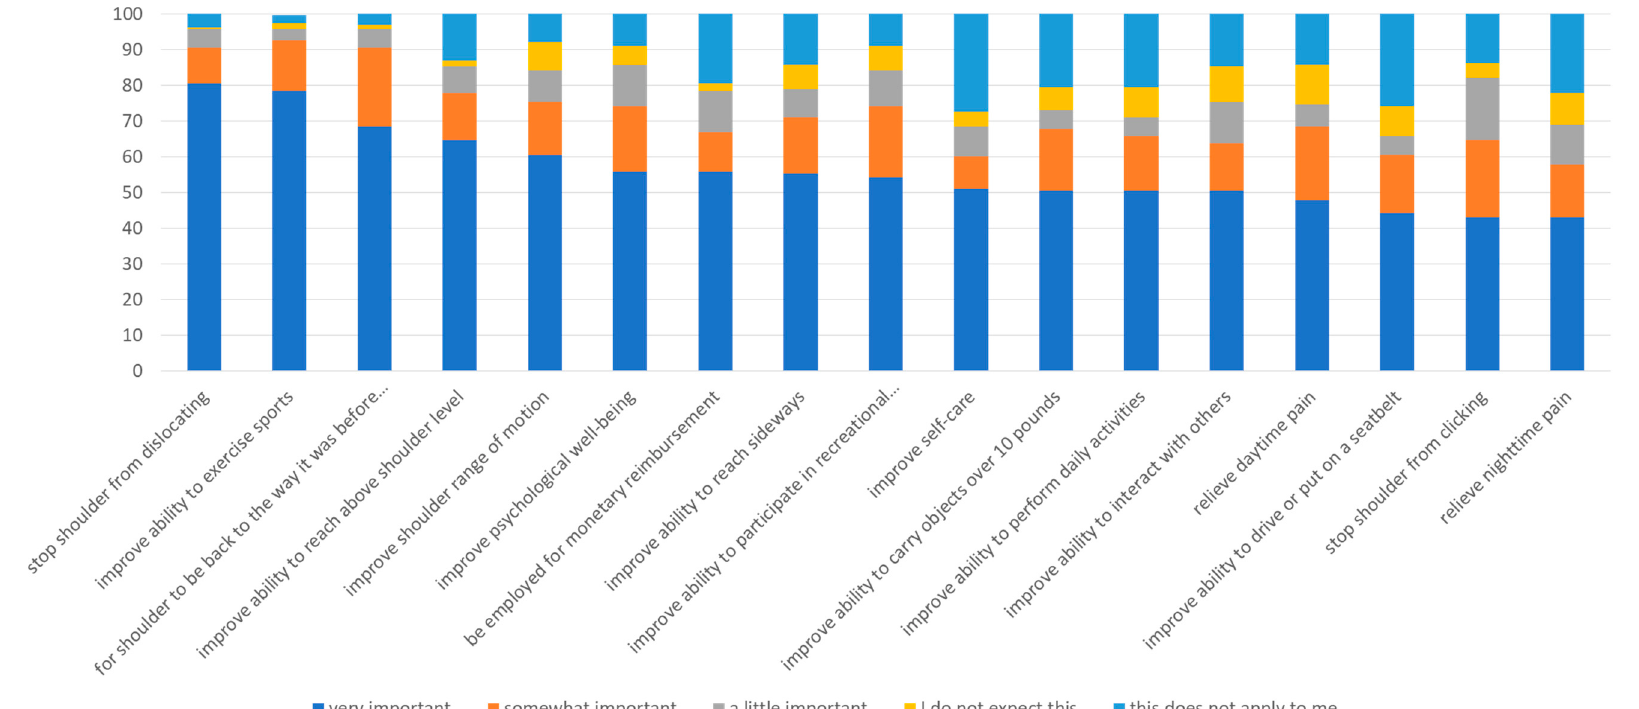
Figure 1. Patients‘ expectations using the Hospital for Special Surgery Shoulder Surgery Expectations Survey‘ (HSS).